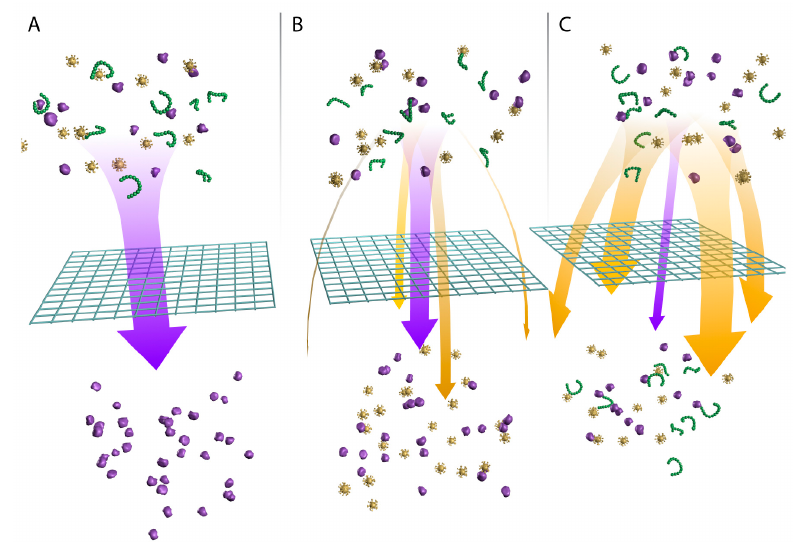
Figure 1. We propose a conceptual model in which dispersal-based assembly processes decrease biogeochemical function. Purple organisms in this figure represent all species that are well-adapted to and are thus good competitors in a given environment. Yellow and green organisms represent all species that are less adapted to the environment than purple organisms. While not displayed for simplicity, we conceptualize multiple species within each color. We acknowledge that the environment influences microbial community composition through effects of both abiotic (e.g., resource availability) and biotic (e.g., competition and predator-prey interactions) factors. We use the term ‘selective filter’ to indicate influences of both factors on an organism’s fitness [29]. ( A ) In a community structured entirely by determinism, selective filtering restricts community composition to species that are well-adapted to prevailing conditions, resulting in enhanced biogeochemical function. ( B ) In communities with moderate stochasticity (here, moderate rates of dispersal), there is an increase in the abundance of maladapted organisms in the community. In turn, the community is less efficient and exhibits lower biogeochemical function. ( C ) Under high levels of stochasticity (here, high rates of dispersal), a large portion of community members are maladapted, resulting in the lowest rates of biogeochemical function.